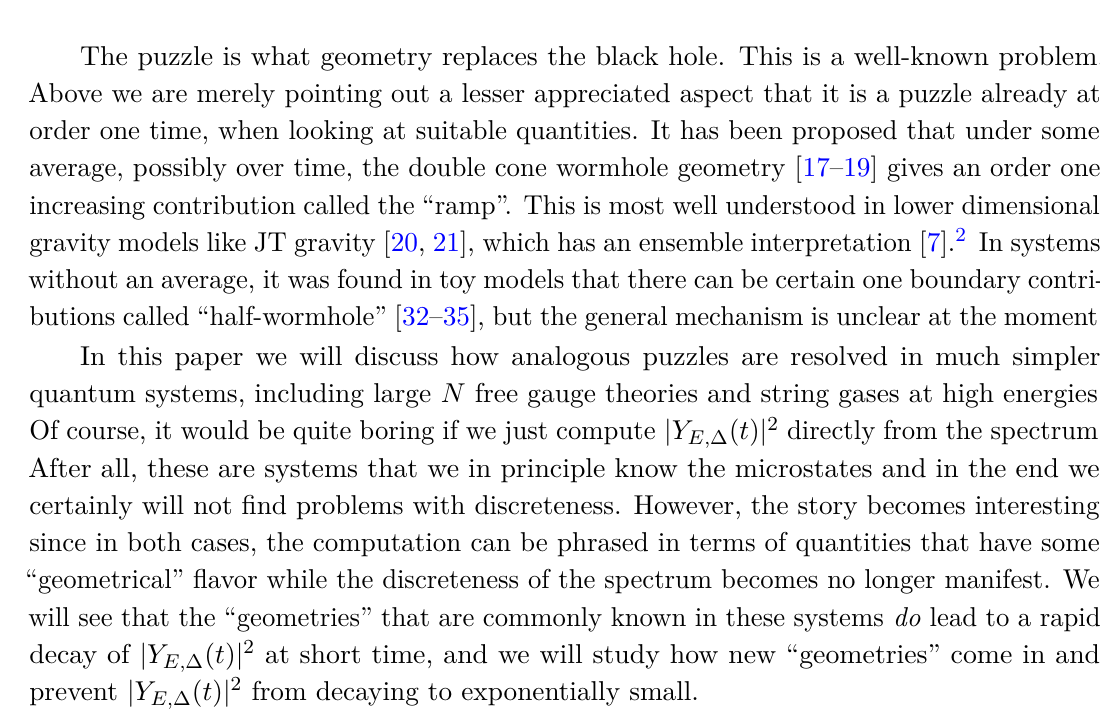
Figure 1 . The spectral form factor | Y E, ∆ ( t ) | 2 for a black hole. The semiclassical answer becomes exponentially small at t ∼ O (1)